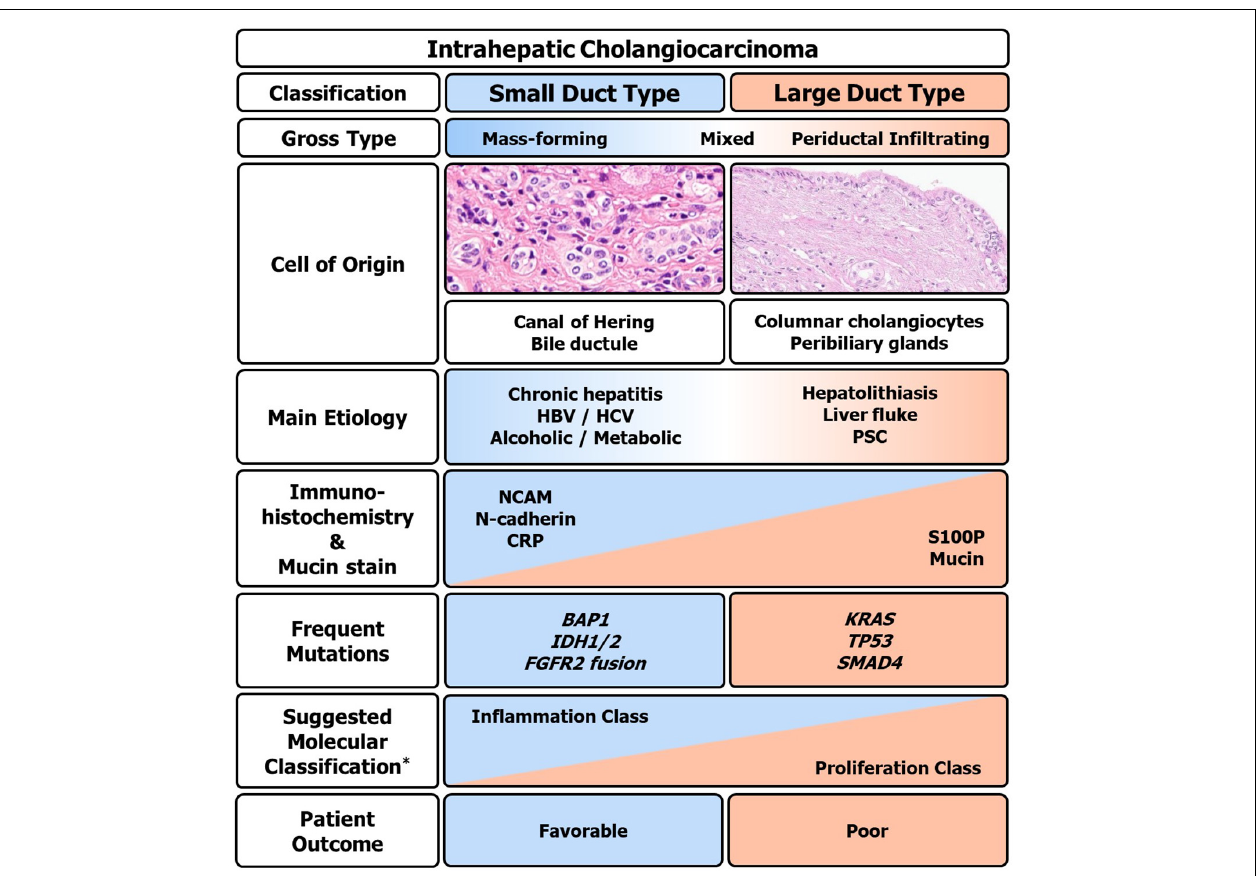
FIGURE 6 | Clinico-pathologic and molecular summary of intrahepatic cholangiocarcinoma (iCCA). Macro and microscopic, immunohistochemical, mutational, and clinical overview of iCCA. HBV, hepatitis B virus; HCV, hepatitis C virus; PSC, primary sclerosing cholangitis; S100P, S100 calcium-binding protein P; NCAM, neural cell adhesion molecule; CRP, c-reactive protein. *Based on the classification by Sia et al.